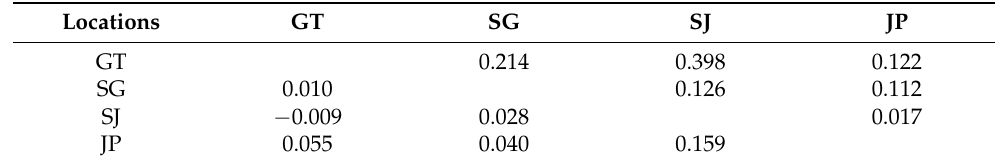
Table 5. Pairwise F ST values among different locations of Schizothorax kozlovi from the upper Yangtze River based on the concatenated Cyt b and COI genes